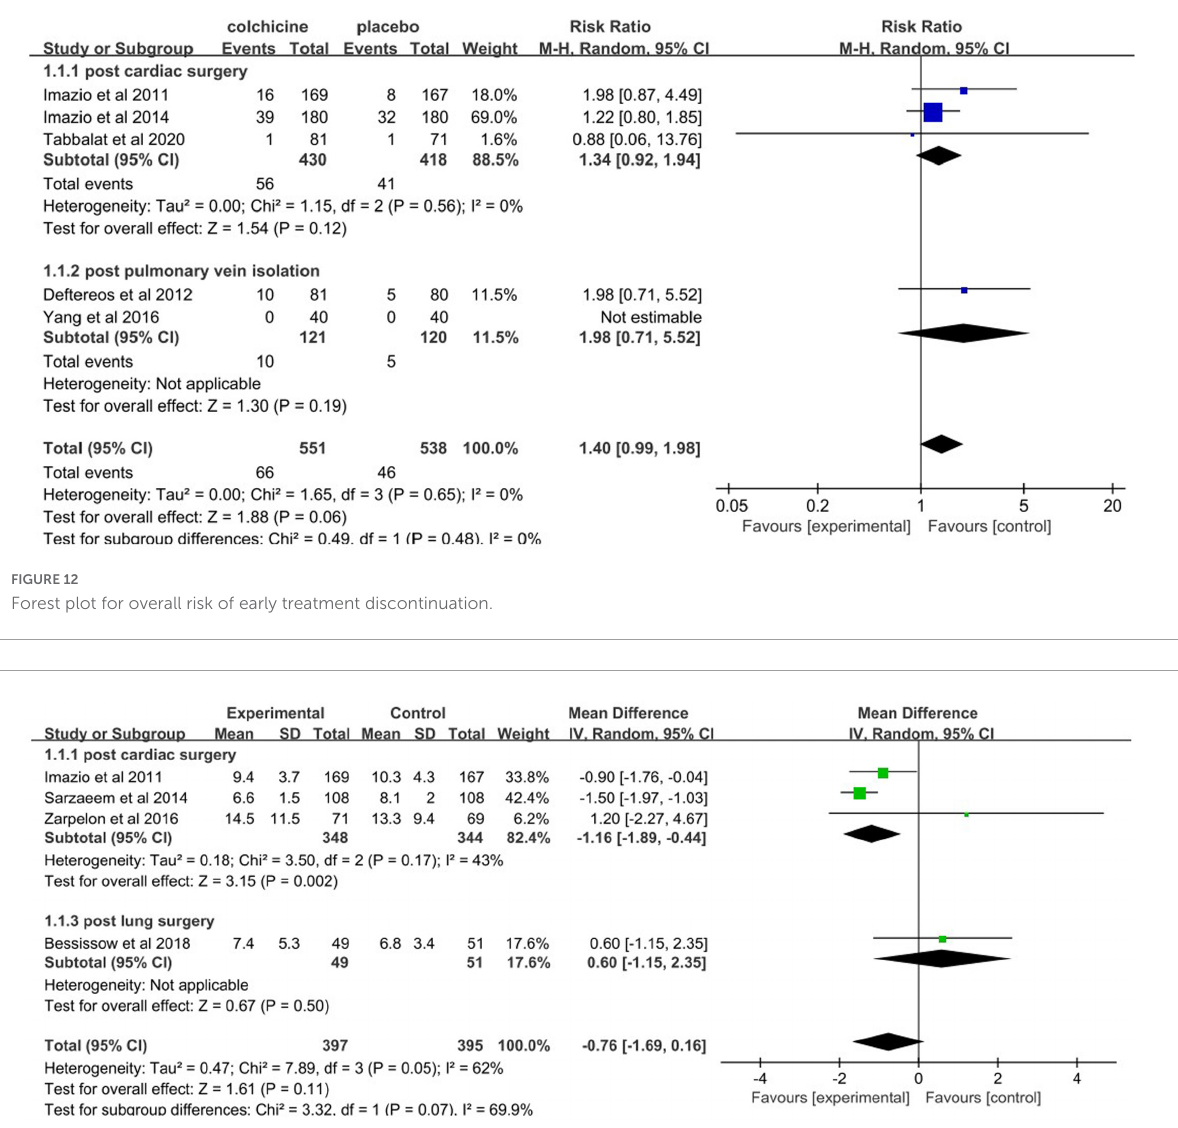
FIGURE13 Forest plot for hospital length of